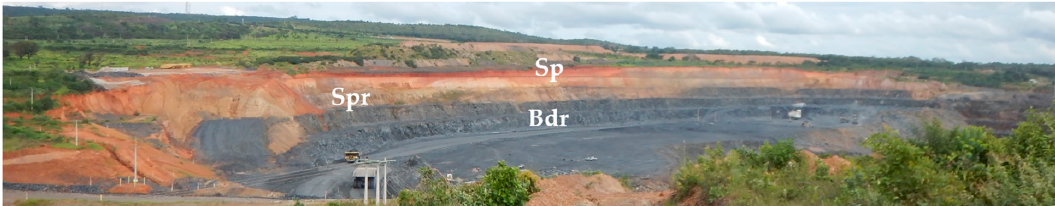
Figure 5. Weathering profile exposed at the southwestern part of the Paracatu mine. The vertical profile shows a red saprolite (sp) transitioning downwards into saprock (spr) and fresh bedrock (bdr). Pit bench height is 12.5 m. The panoramic view looks north-north-east (NNE).